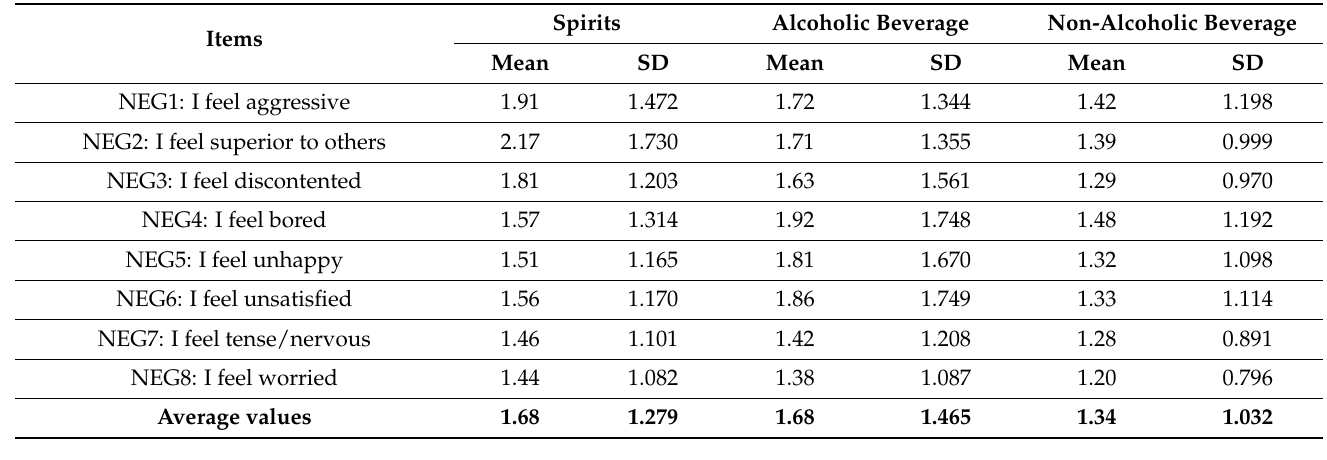
Table 3. Descriptive measures for negative emotions.